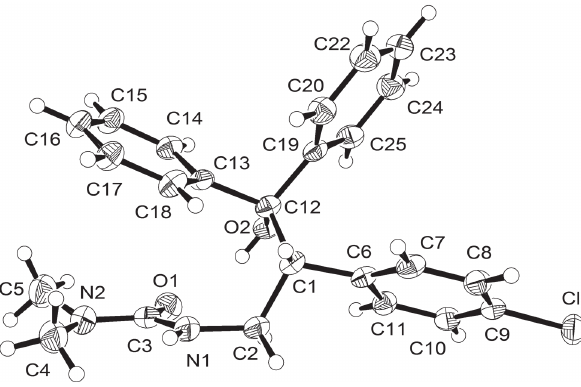
Table 2: Fractional atomic coordinates and isotropic or